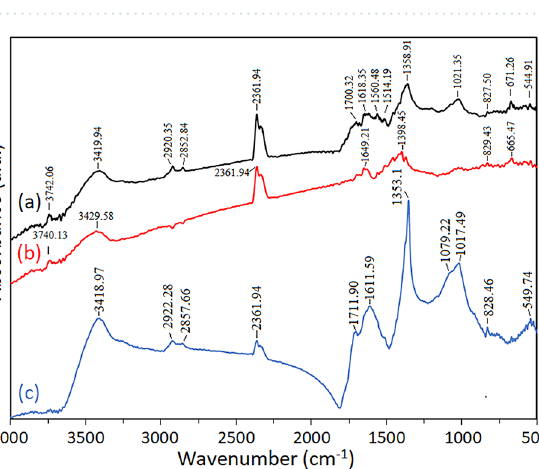
Figure 3. Zeta potential analysis of ( A ) AgNP-W, ( B ) AgNP-F and ( C ) AgNP-S.